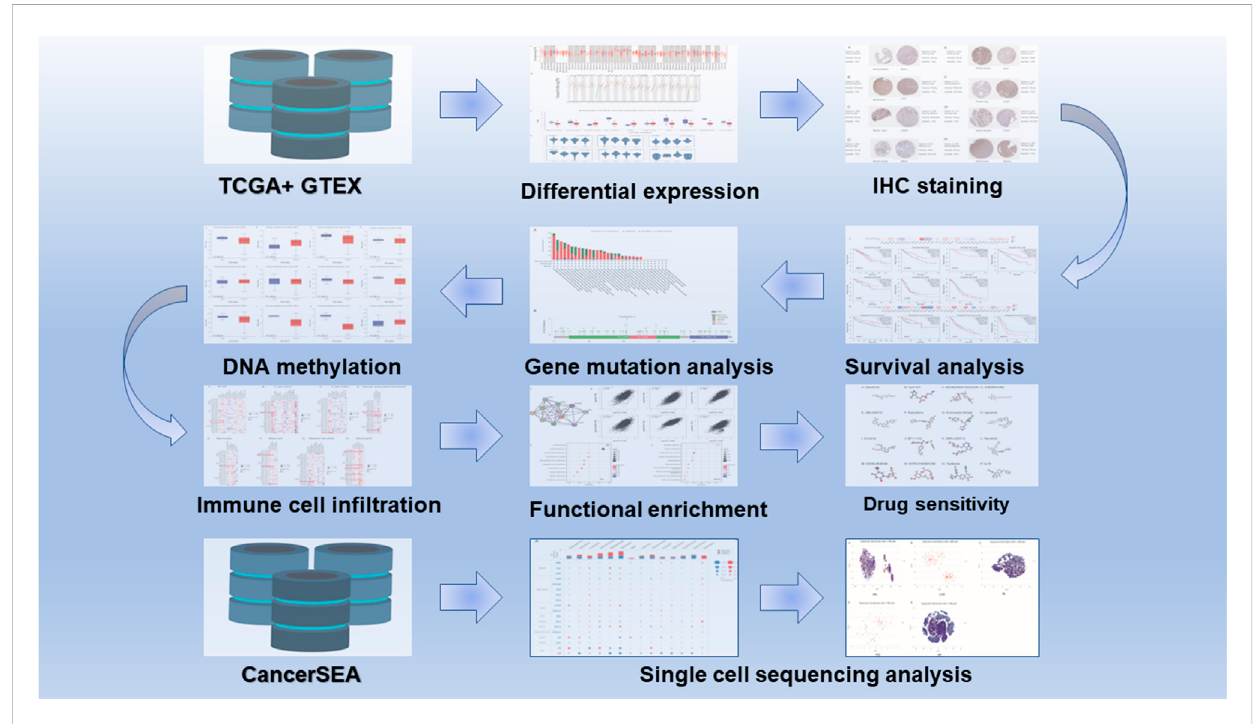
FIGURE 1 Flow chart for pancancer analysis of DLD